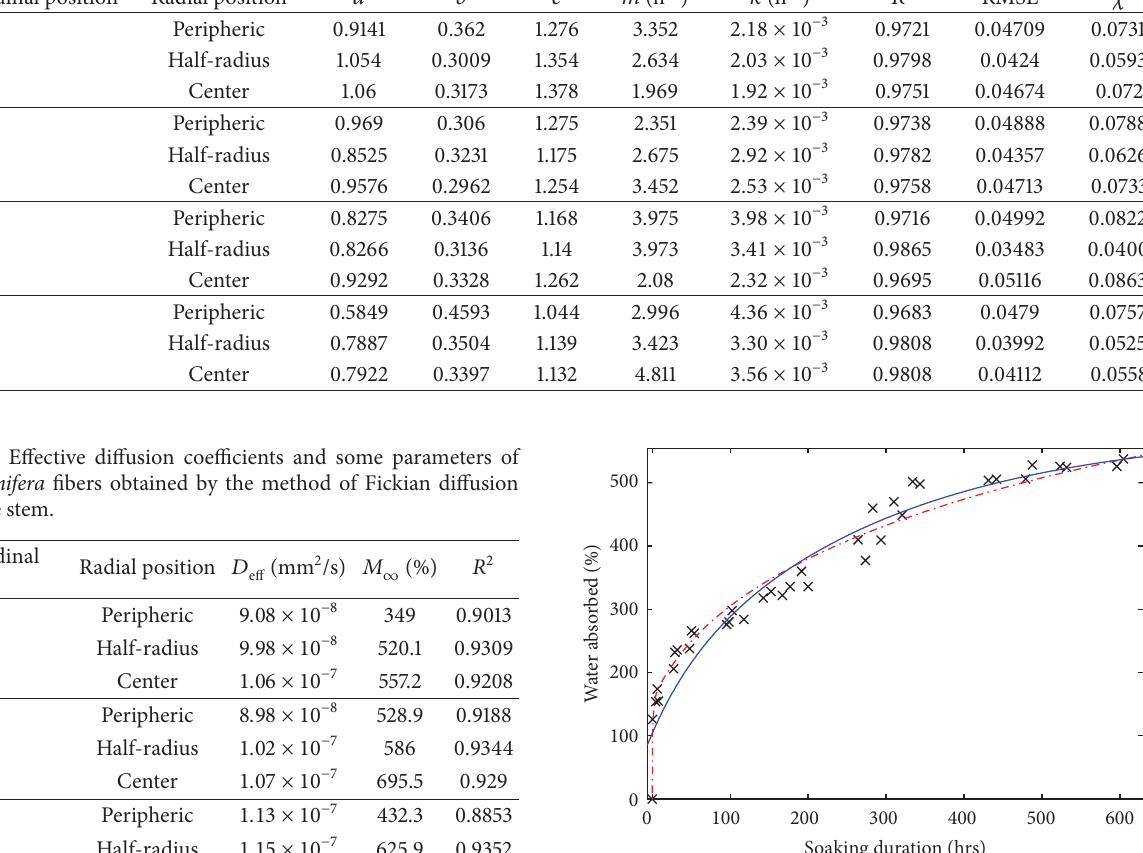
Table 4: Parameters obtained for the proposed model of Raffia vinifera fibres along the stem. Longitudinal position